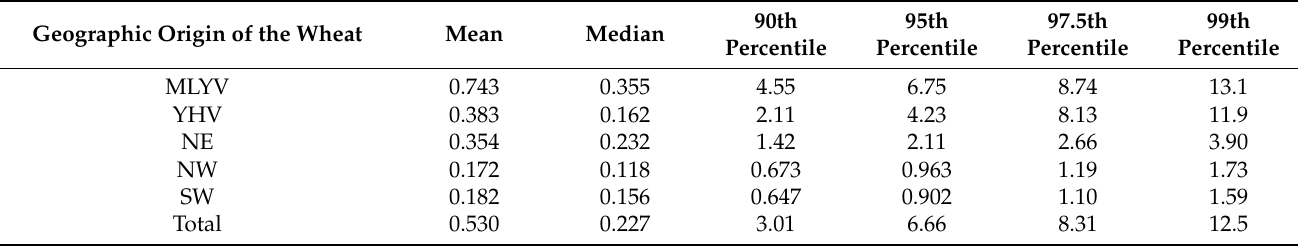
Table 3. T The estimated dietary DON exposure through wheat-based products from different areas for 7- to 10-year-old boys determined by point evaluation ( µ g/kg bw/day).